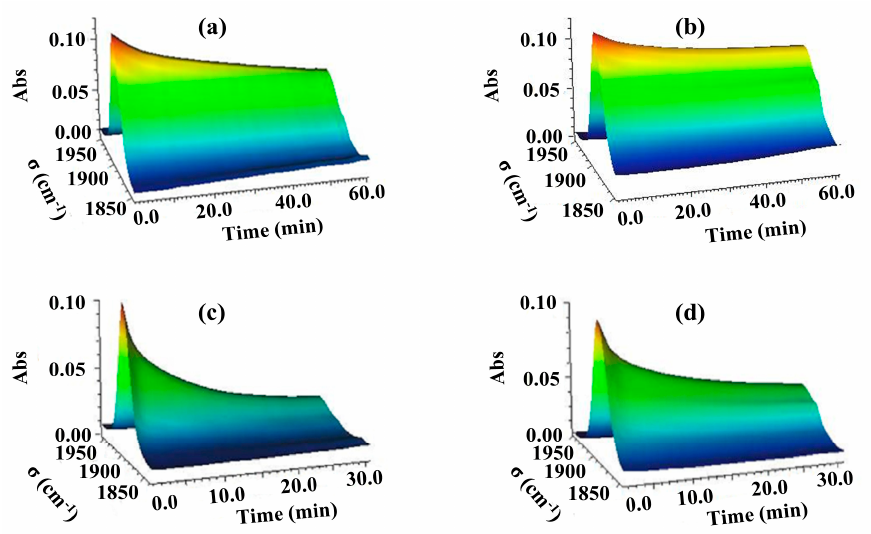
Figure 2. Time resolved infrared spectra of the Ru-Lbpy 1 and Ru-Lbpy 2 complexes upon irradiation with 420 nm light at an intensity of 75 mW · cm − 2 for 60 min ( a , b ) and Xe light at an intensity of 300 mW · cm − 2 ( c , d ) for 30 min, respectively.